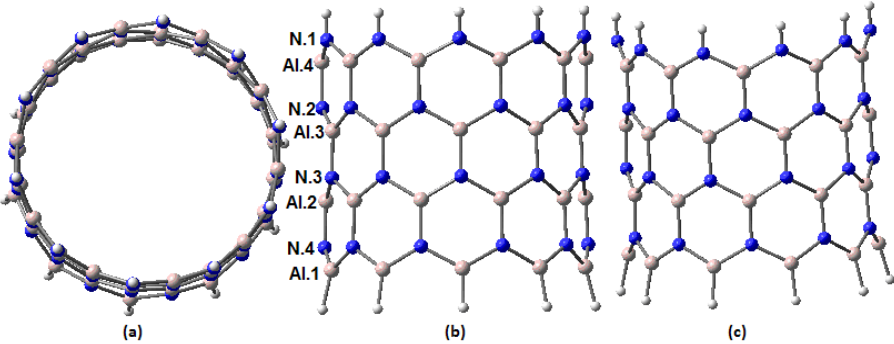
Figure 1. The 3D view (a) and the 2D view of the front side (b) and the back side (c) of the pristine model of (10, 0) AlNNT.